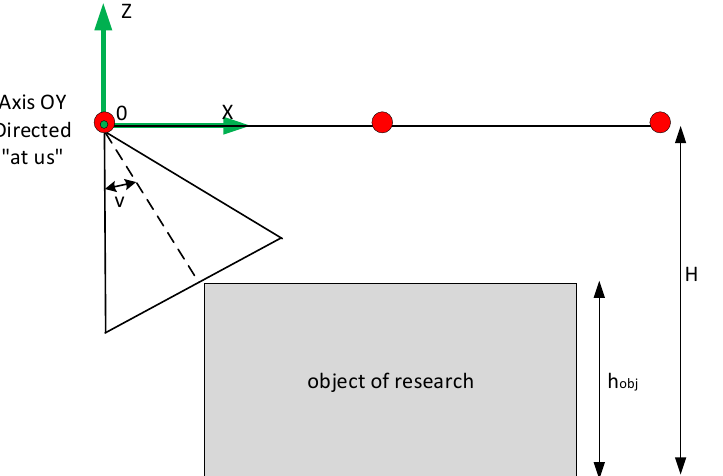
Figure 4. Illustration relating the parameters used in the formulas for calculating the rotation of the stabilizer. The red dots are the positions of the camera in space.